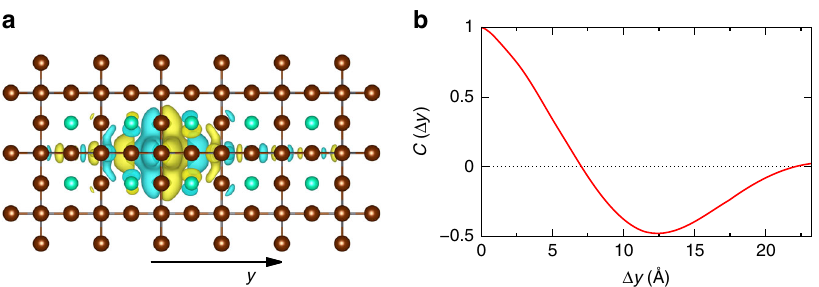
Fig. 3 Resonant bonding in CsPbBr 3 . a Iso-surface representation of the charge-density difference that is induced in the crystal upon displacing a Pb atom, which shows a long-range behavior. b Autocorrelation function of the change in the electrostatic potential energy calculated for the direction indicated in panel a. It represents a disorder potential for the electronic states and also shows a long-range behavior